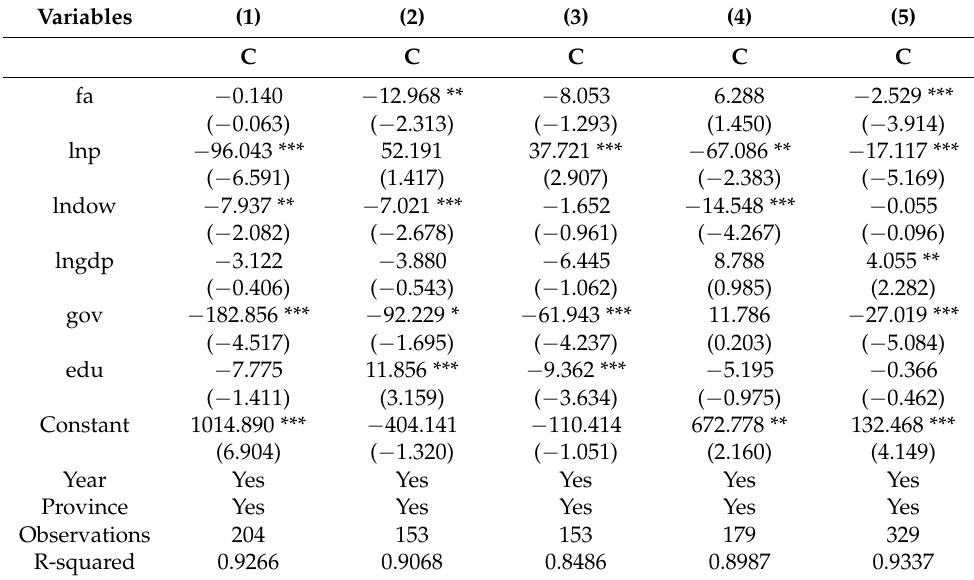
Table 4. Heterogeneity